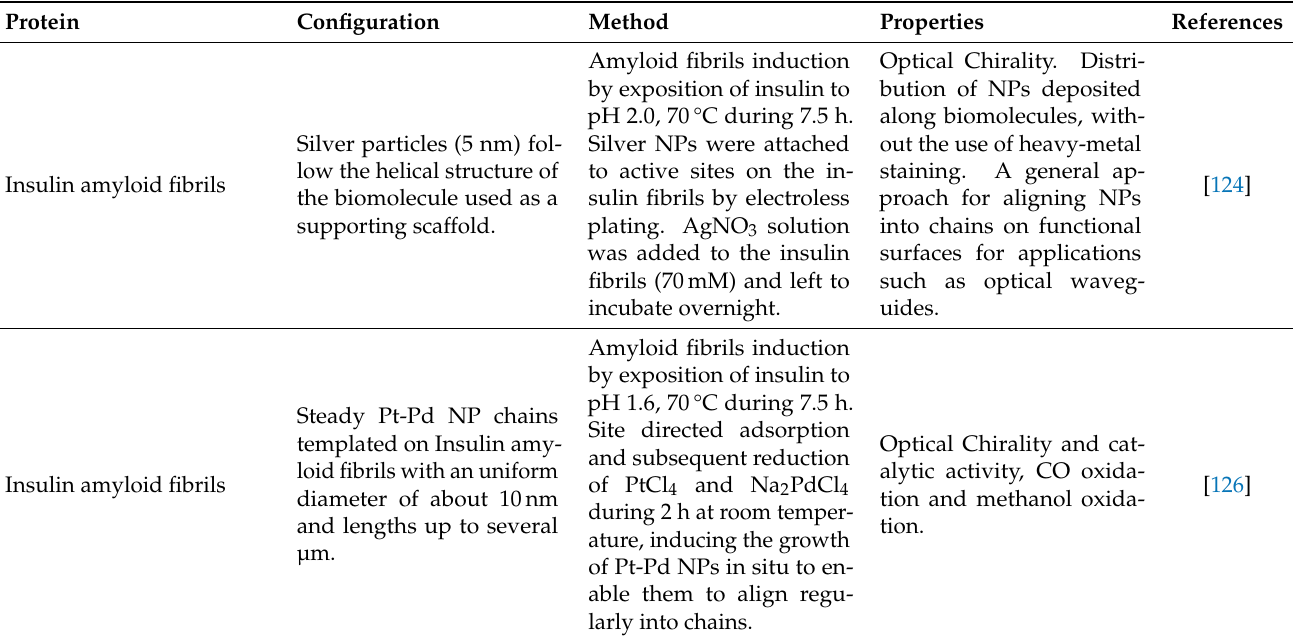
Table 2. Examples of protein based structured material and their optical